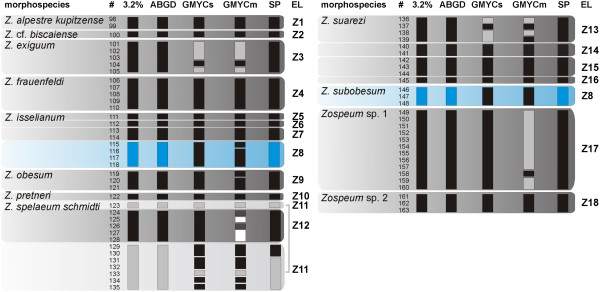
Molecular delimitation of Zospeum evolutionary lineages. Results of the five genetic delimitation approaches are indicated. For Zospeum, 66 specimens (#) comprising 10 morphospecies and two undescribed taxa are analysed. A conservative strategy identified 18 evolutionary lineages (EL; Z1-Z18). Specimens clusters identified under each single delimitation method (3.2%, ABGD, GMYCs, GMYCm and SP) are indicated by black boxes. Grey boxes refer to clustered specimens within a single morphospecies (e.g. 3.2%, # ‘123’ + ‘129-135’), colored boxes to specimens between different morphospecies (e.g. 3.2%, # ‘115-118’ + ‘146-148’).